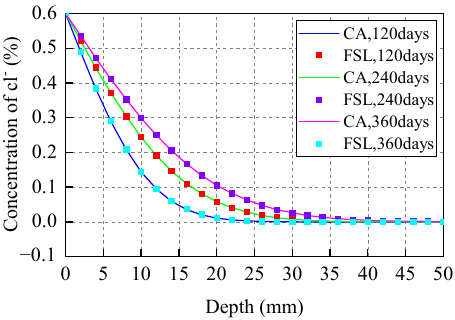
Figure 5. Simulation results for chloride ion concentration in concrete cross-section under various corrosion times: ( a ) t = 120 days; ( b ) t = 240 days; ( c ) t = 360 days. From Figure 4, chloride ion concentration in concrete cross-section increases with time and decreases with depth. A good correlation is witnessed between analysis results of FSL and those predicted by the CA model, and the maximum deviation between the two calculations does not exceed 3%. This demonstrates that the 3D CA model proposed previously is feasible and reasonable to simulate the chloride ion diffusion process in con- cretes. 3. Improved 3D CA Model 3.1. Stress Level Effect on Chloride Ion Diffusion For concrete structures in actual engineering, most of the structures are subjected to loads during service. However, before the load was applied, the concrete had many small cracks, pores, and micro-defects inside due to the characteristics of the structure itself. Therefore, once a load acts on the structure, stress concentration will occur in these places, resulting in a significant variation in concrete internal pore structure, thereby affecting the erosion ability of chloride ions in concrete [31,35]. Now that a large number of studies investigate the influence of applied load on chloride ion diffusion, load effect on chloride ion diffusion is generally taken into account by the multiplication of the original chloride ion diffusion coefficient by the corresponding influence coefficient [36,37]. Therefore, un- der bending loads, the relationship between concrete cross-section stress distribution and chloride ion diffusion coefficient in concretes is stated as: 0 s